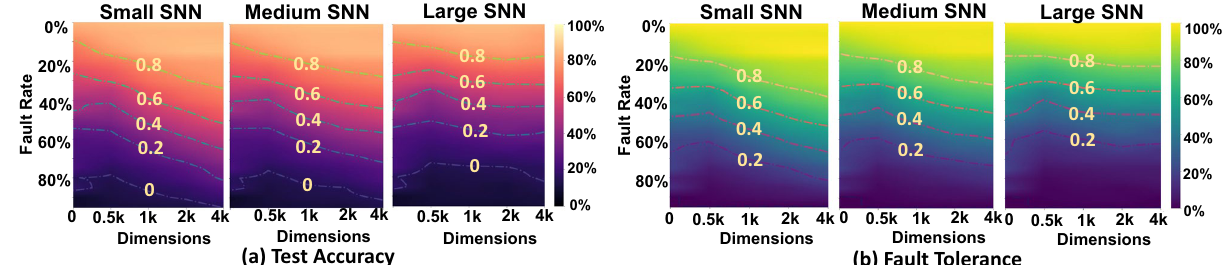
Figure 6. The test accuracy and fault tolerance of SpikeHD under different SNN and HDC parameter settings. ( a ) Test accuracy is measured by the classification accuracy of the MNIST test data from the model given SNN size, dimension of the HDC memory, and proportion of faulty parameters. ( b ) Fault Tolerance is measured by the quality of prediction sustained under memory failure, using its 0-fault counterpart and a random classifier (which has a test accuracy of 0.1 in the case of MNIST) as